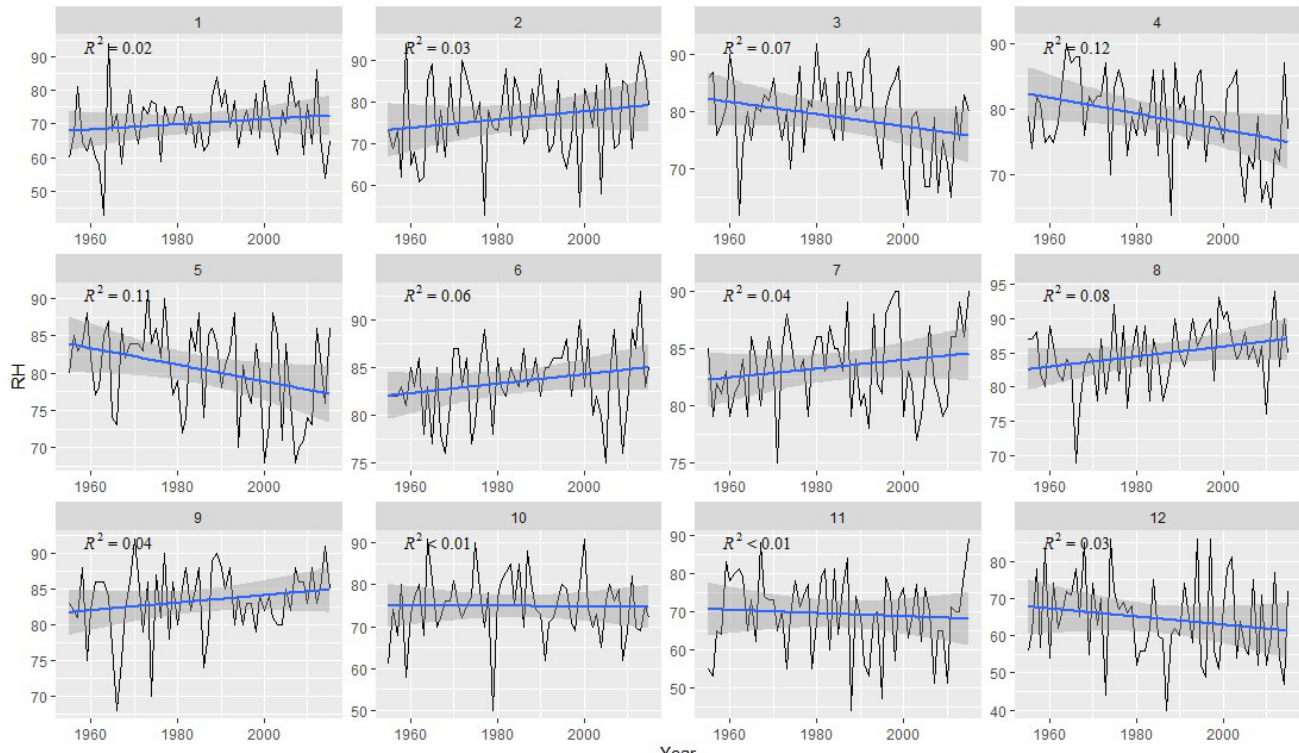
Figure A4. Climate trends of monthly relative humidity during 1955–2014. Table A1. Values of standard tree ring width chronology.